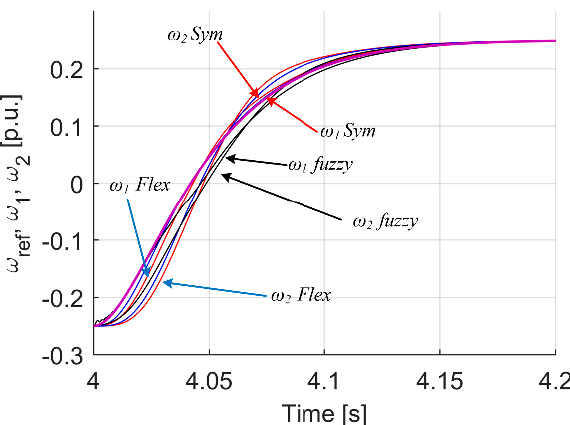
Figure 21. Transients of difference between motor and reference speed for analyzed controller cases.